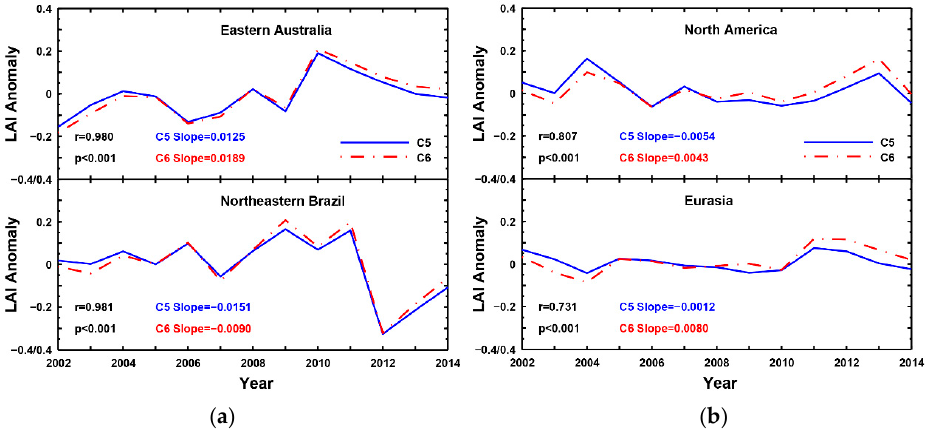
Figure 5. Comparison of anomalies of spatially averaged LAI values from C5 (blue solid lines) and C6 (red dashed lines). Panel ( a ) shows the anomaly of annual averaged LAI in two precipitation-limited regions (Eastern Australia, 20 ˝ S–40 ˝ S, 145 ˝ E–155 ˝ E and Northeastern Brazil, 3 ˝ S–12 ˝ S, 35 ˝ W–45 ˝ W). Panel ( b ) shows the anomaly of growing season (May to September) averaged LAI in two temperature-limited high latitude (>60 ˝ N) regions (North America and Eurasia). Correlation coefficient (r) between the two MODIS collections and its significance (p) are given in each panel. Moreover, slopes are provided as indicators of the trend of inter-annual